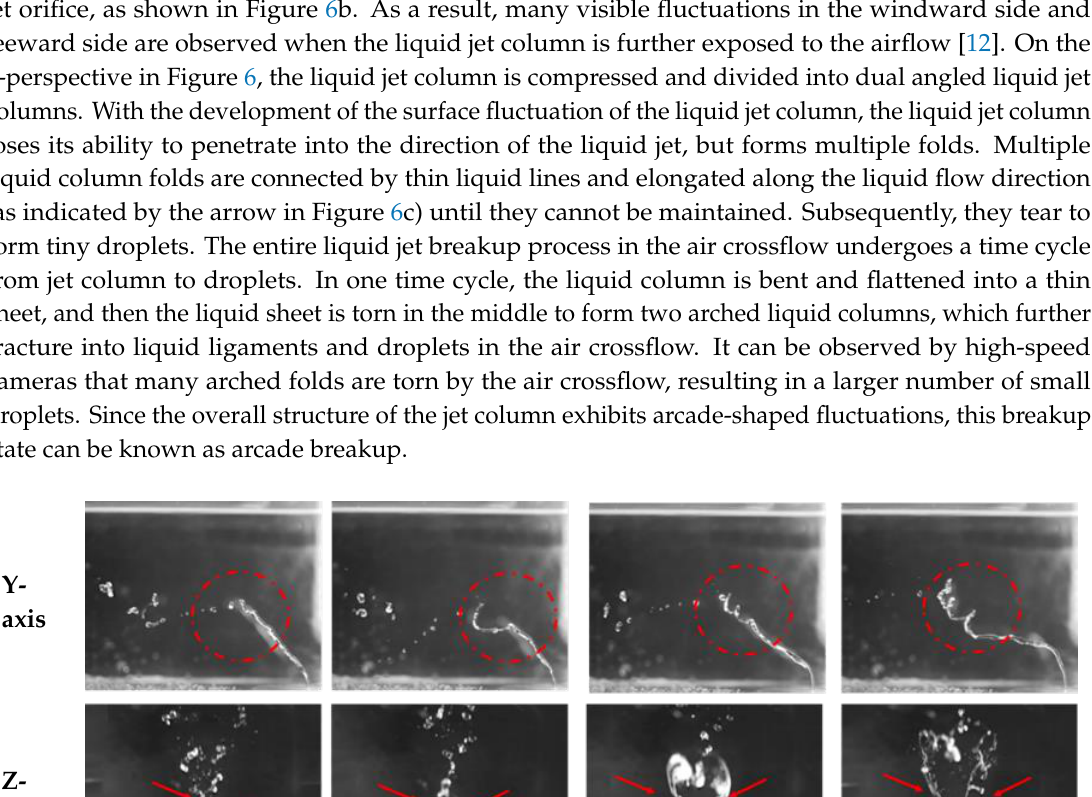
Figure 6. Arcade breakup mechanism for We g = 2.90 We j = 245.76 d j = 1 mm.